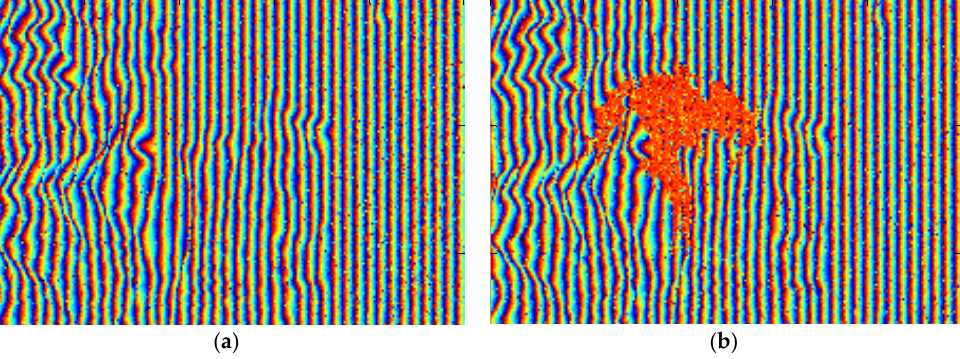
Figure 7. Comparison between the interferograms before and after SAR deceptive jamming: ( a ) interferogram before jamming; and ( b ) interferogram after jamming.